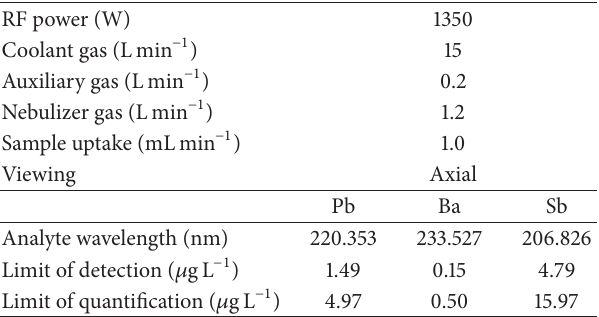
Table 1: Main ICP OES